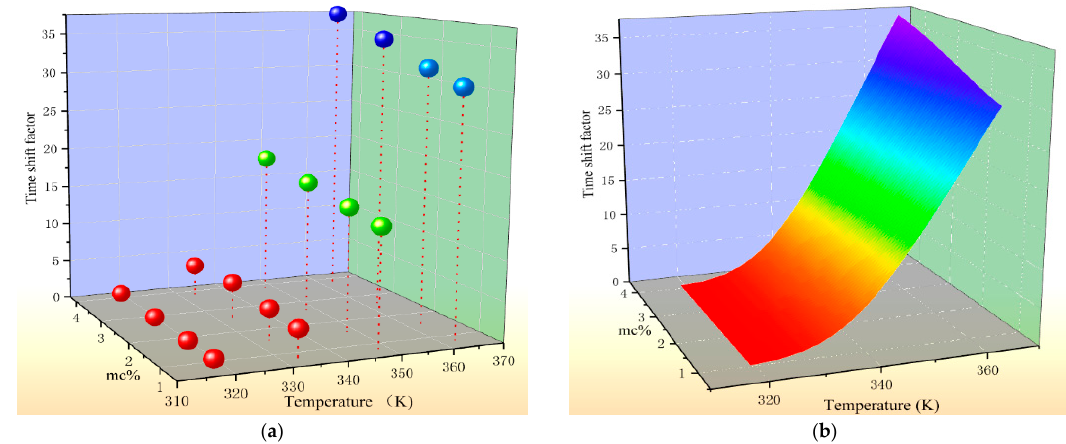
Figure 4. The variation law of time-shift factor. ( a ) The scatter plot of test temperature, mc% the and time-shift factor; ( b ) The fitting surface of the time-shift factor. Table 3. Surface fitting equation of the time-shift factors.